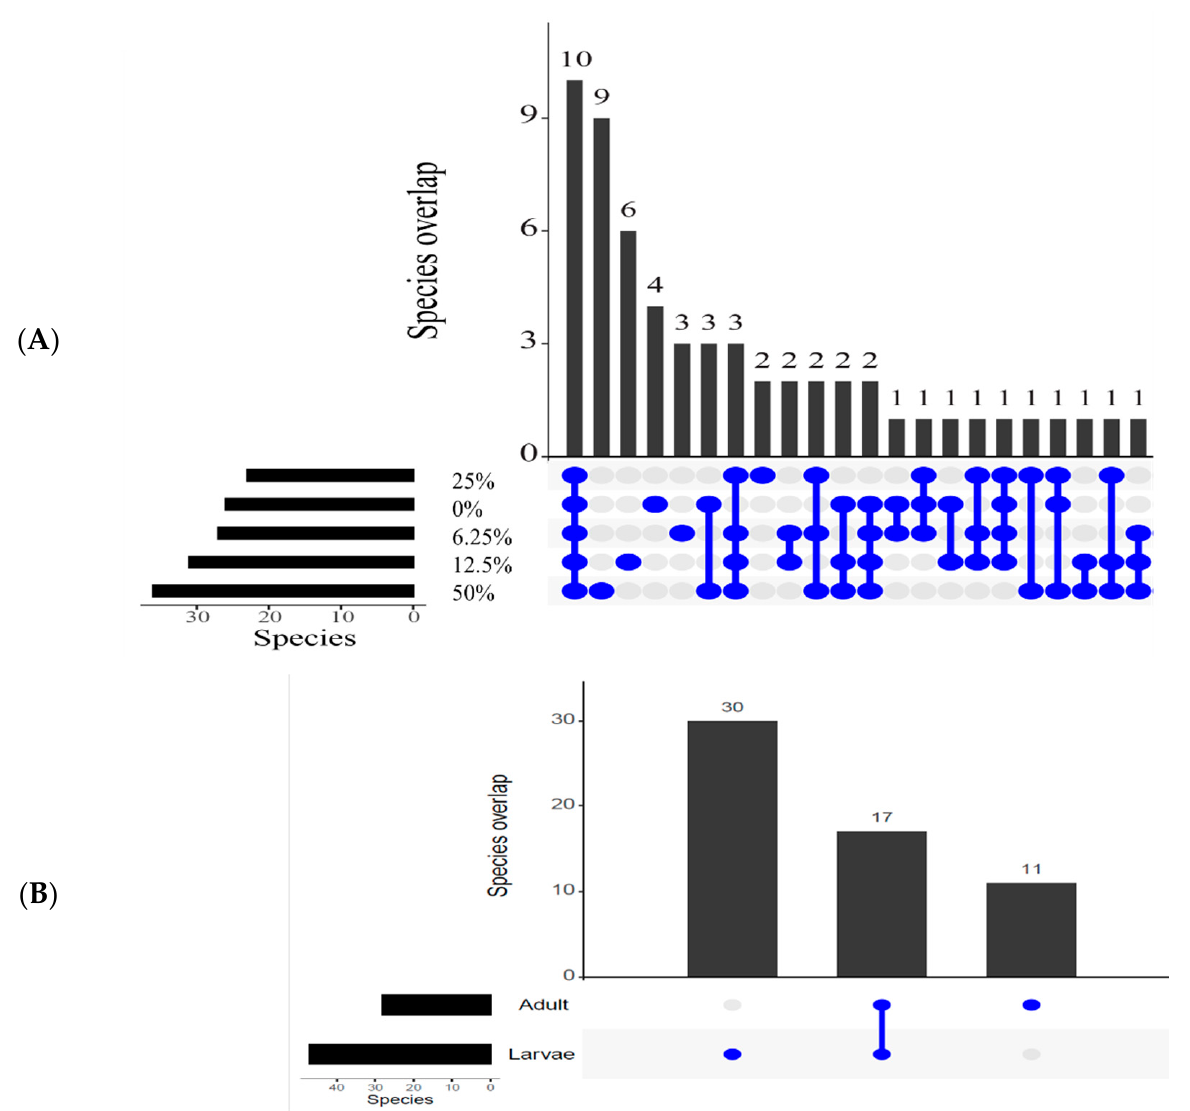
Figure 5. Overlapping gut microbiota in An. merus reared in varying larval salt concentrations. ( A ) Overlapping species in adults originating from larval different treatments. ( B ) Overlapping species in adults and larvae. Individual dots indicate numbers of individual species. Joined dots indicate numbers of shared species between the relevant concentrations.